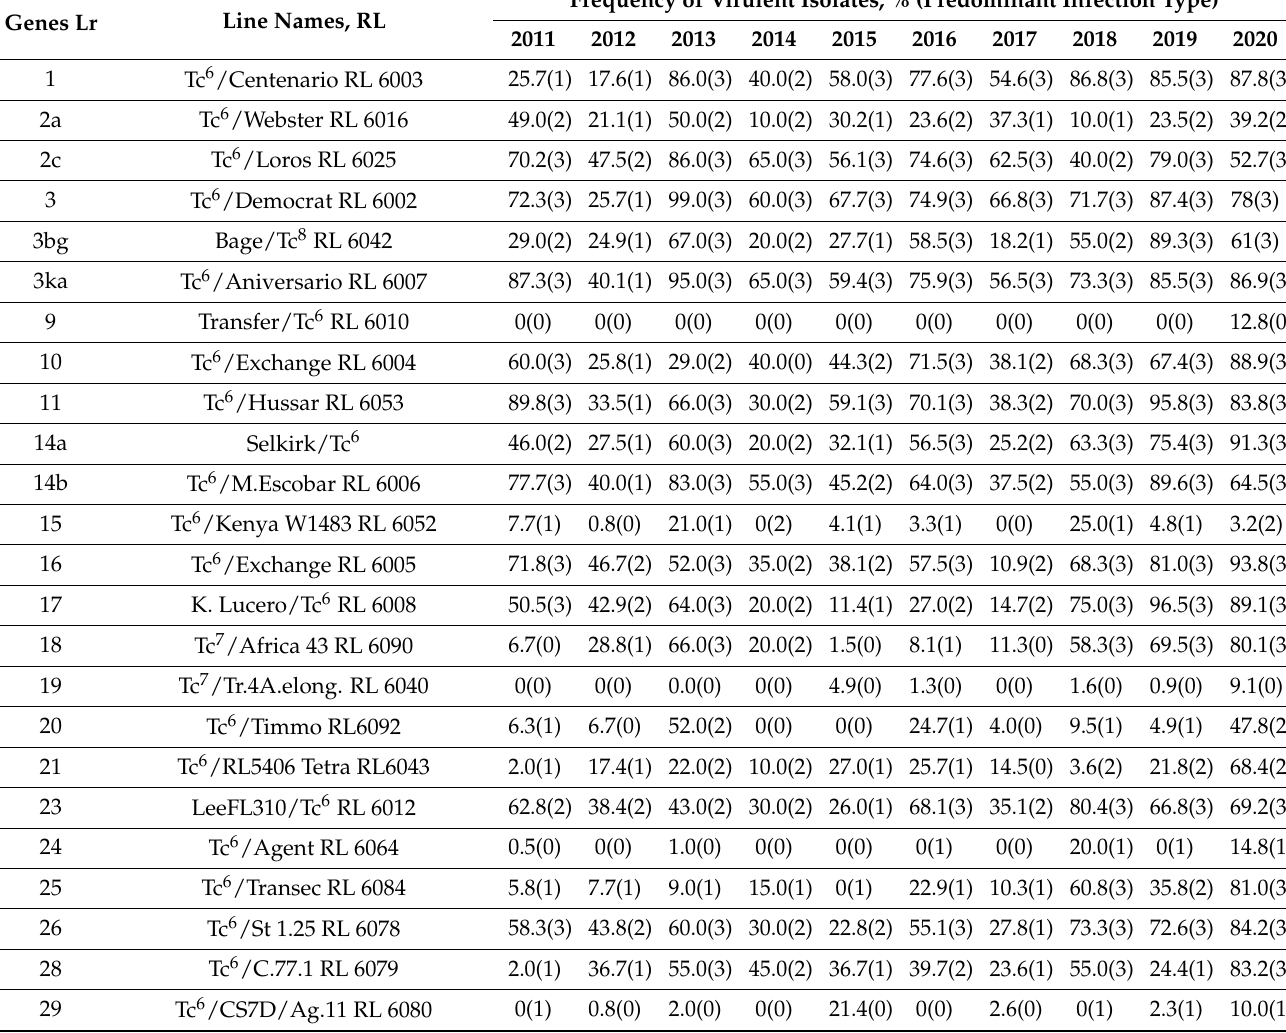
*—studies were not carried out due to the lack of seed material. Table 2. The frequency of virulent and predominant infection types P. triticina isolates of the